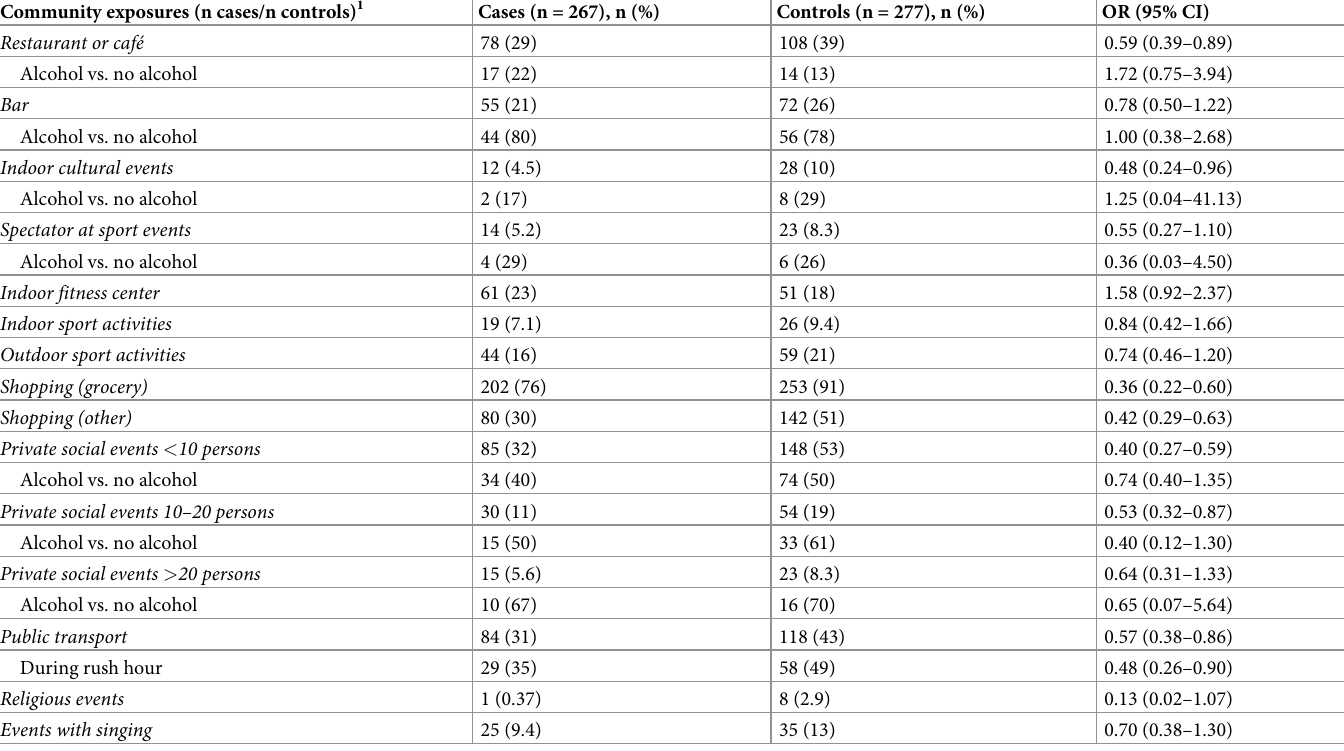
Table 5. Number, proportion and odds ratios related to community exposures without close contact cases and controls, Denmark, June 2021. Community exposures (n cases/n controls) 1